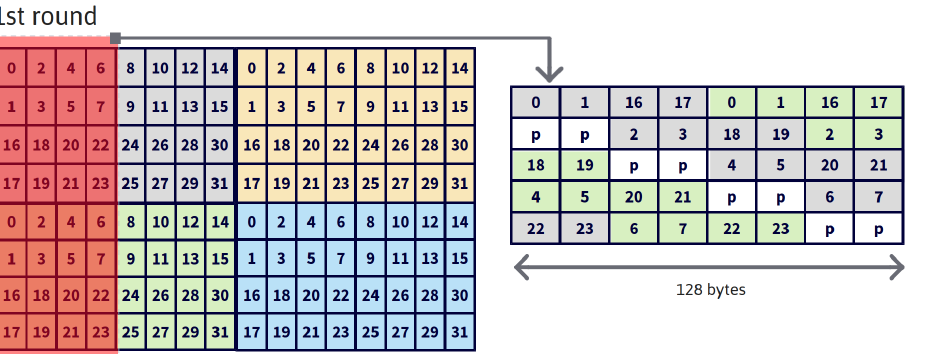
Figure 5. Lane ID arrangement for output transform buffer ( right side , being p the padding elements) and pre-transform output data transposed in the first round ( left side